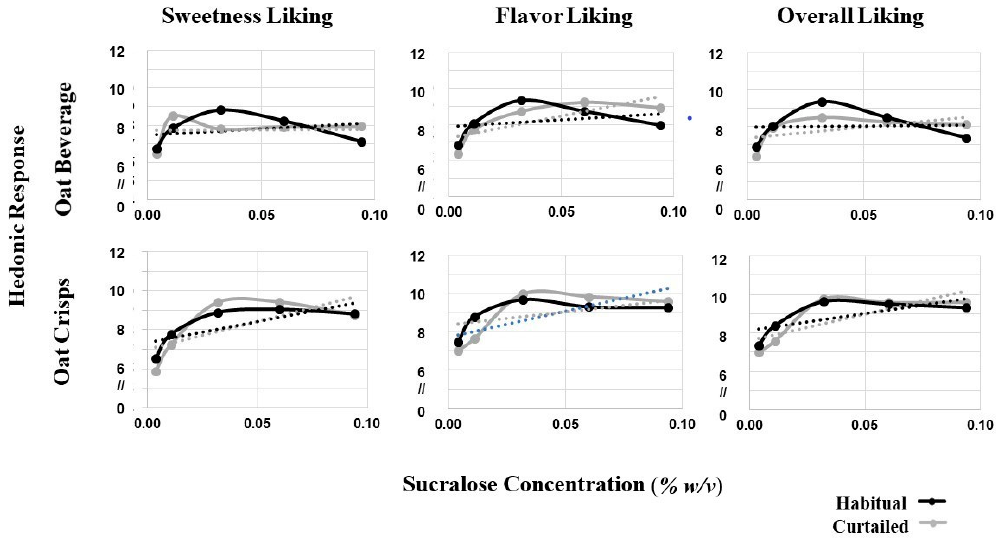
Figure 3. Comparisons between liking responses for di ff erent hedonic measurements assessed with a 15 cm visual analog scale for the oat crisp and oat beverage. A significant main e ff ect of sleep was observed for both flavor ( p = 0.017) and overall liking slopes ( p = 0.047), indicating overall and flavor liking slopes were significantly steeper after curtailment for both oat products. No e ff ect was observed for sweetness. No interaction between sleep condition and food form was observed. A significant food form e ff ect on the overall ( p = 0.026) and sweetness liking ( p = 0.003) slopes was observed, indicating a steeper slope for oat crisps compared to oat beverage regardless of sleep condition.